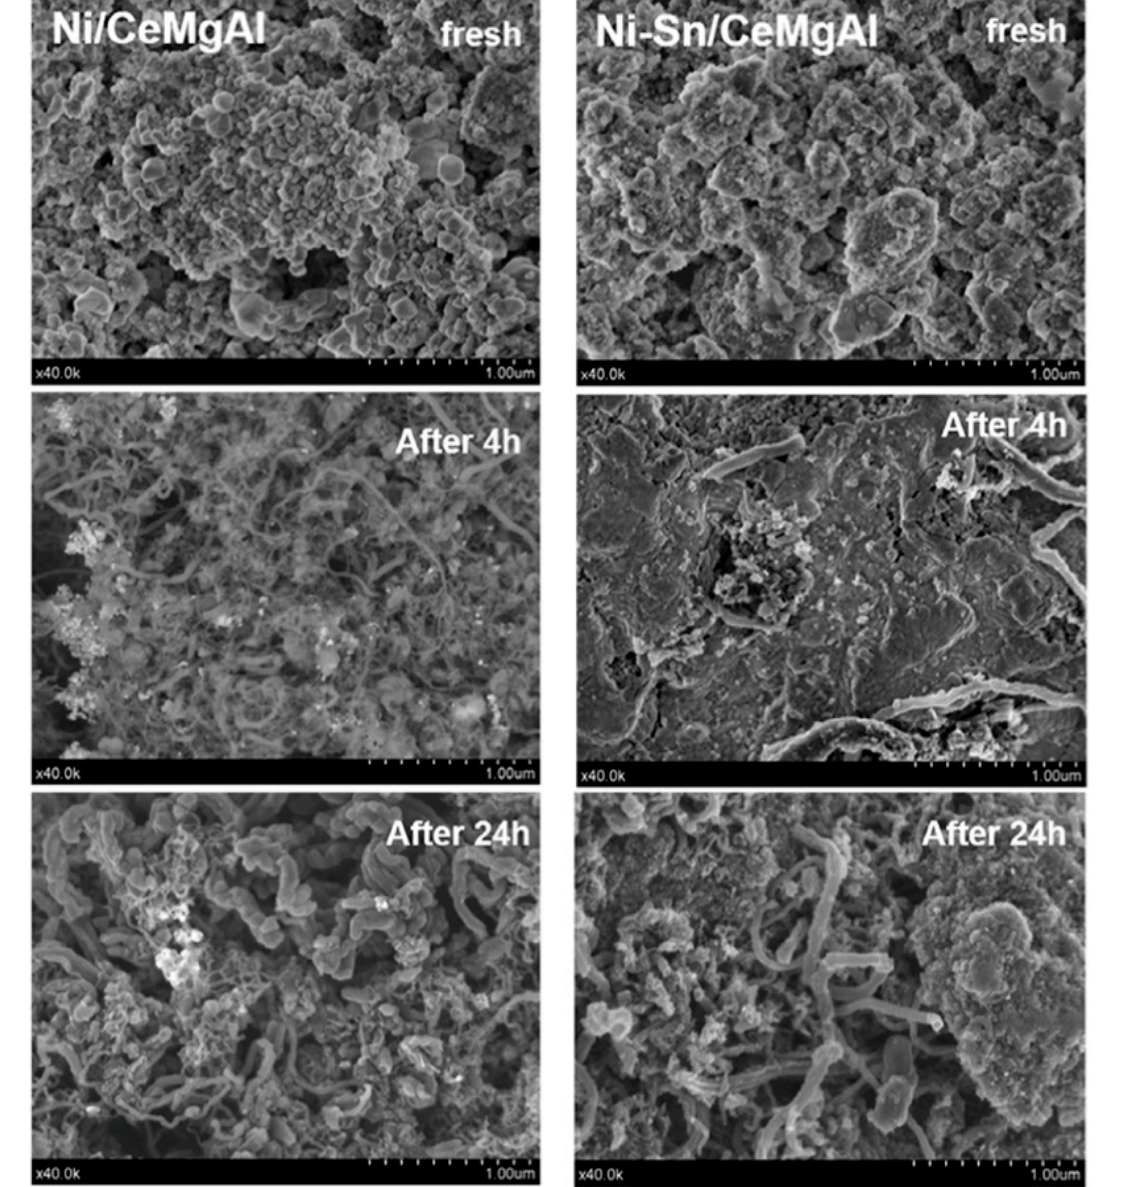
Figure 6. SEM images of fresh and used Ni/CeMgAl and Ni-Sn/CeMgAl catalysts in SR of glycerol at 750 °C [79] (used with copyright permission).